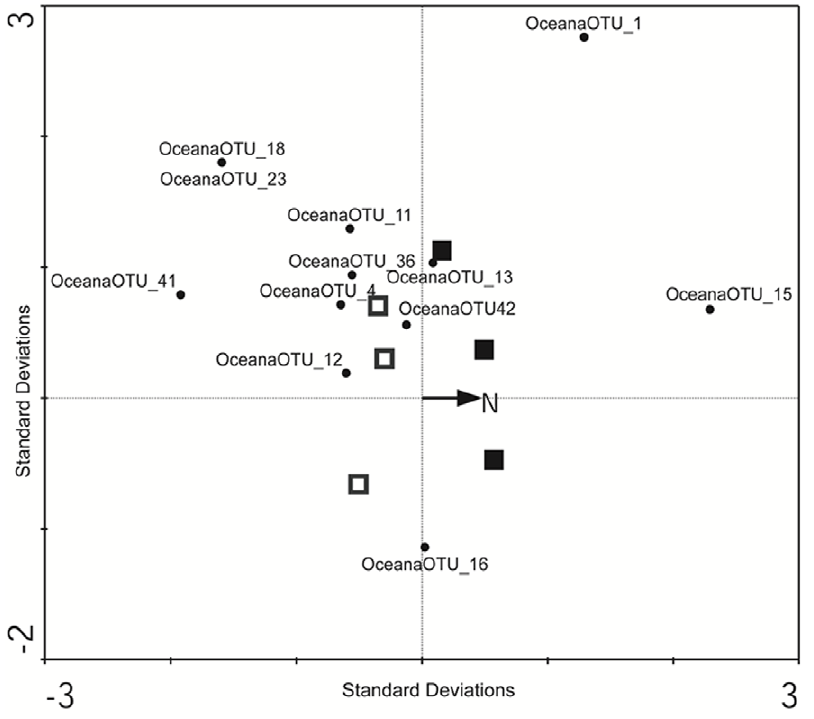
Figure 4. Triplot based on a Canonical Correspondence Analysis showing the relationships between samples of a fungal community developing under ambient conditions of N deposition (open squares) and under conditions of simulated elevated N depostion (closed squares), the relative abundance of the 12 most widespread fungal Operational Taxonomic Units (OTUs, black circles), and total N depostion (vector) in the forest floor of a maple dominated hardwood ecosystem. The primary axis accounts for 22% of the variance in OTU relative abundances; the second axis a further 37%. The relationship between fungal relative abundances and total N is not significant (Monte Carlo P=0.52). OTU codes correspond to the phylogenies (Fig. 2, Fig. 3): OceanaOTU_1, Typhula sp; OceanaOTU_4, Mycena sp; OceanaOTU_11, Entoloma sp; OceanaOTU_12, Athelia sp.; OceanaOTU_13, Gomphales sp.; OceanaOTU_15, Ceratosebacina sp.; OceanaOTU_16, Ceratobasidium sp.; OceanaOTU_18, Sistotrema sp.; OceanaOTU_23, unidentified Ascomycota; OceanaOTU_36, Leotiomycete sp.; OceanaOTU_41, Leotiomycete sp.; OceanaOTU_42, Leotiomycete sp.